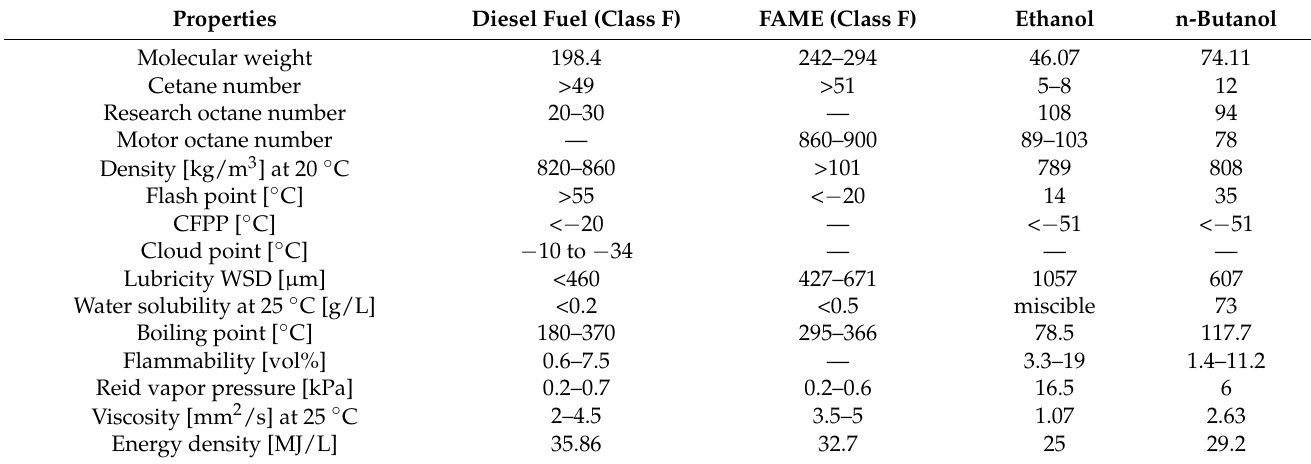
Table 2. Comparison of the properties of butanol isomers with other conventional fuels